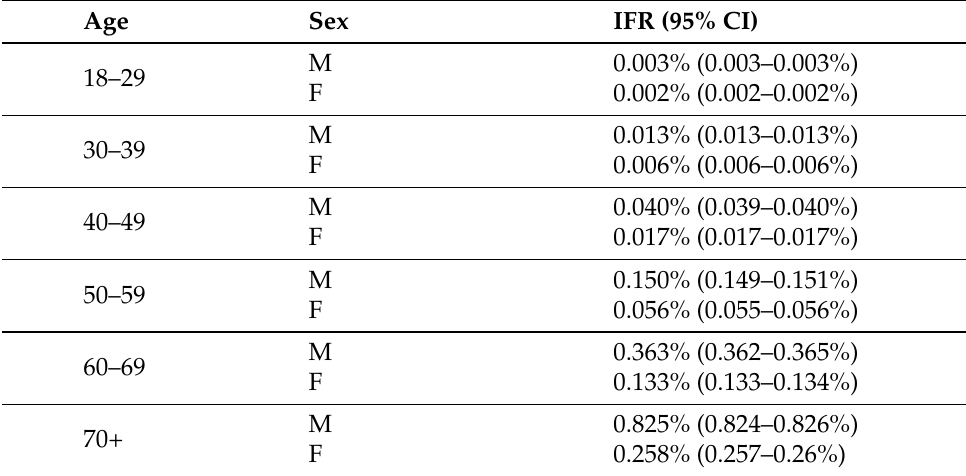
Table 1. Age- and Sex-wise IFR estimates for Tamil